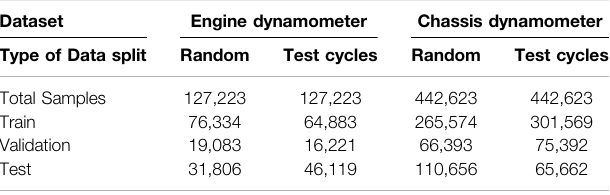
TABLE 1 | Description of datasets (engine and chassis dynamometer. Types of data splits (random and test cycles) and train/validation/test splits.